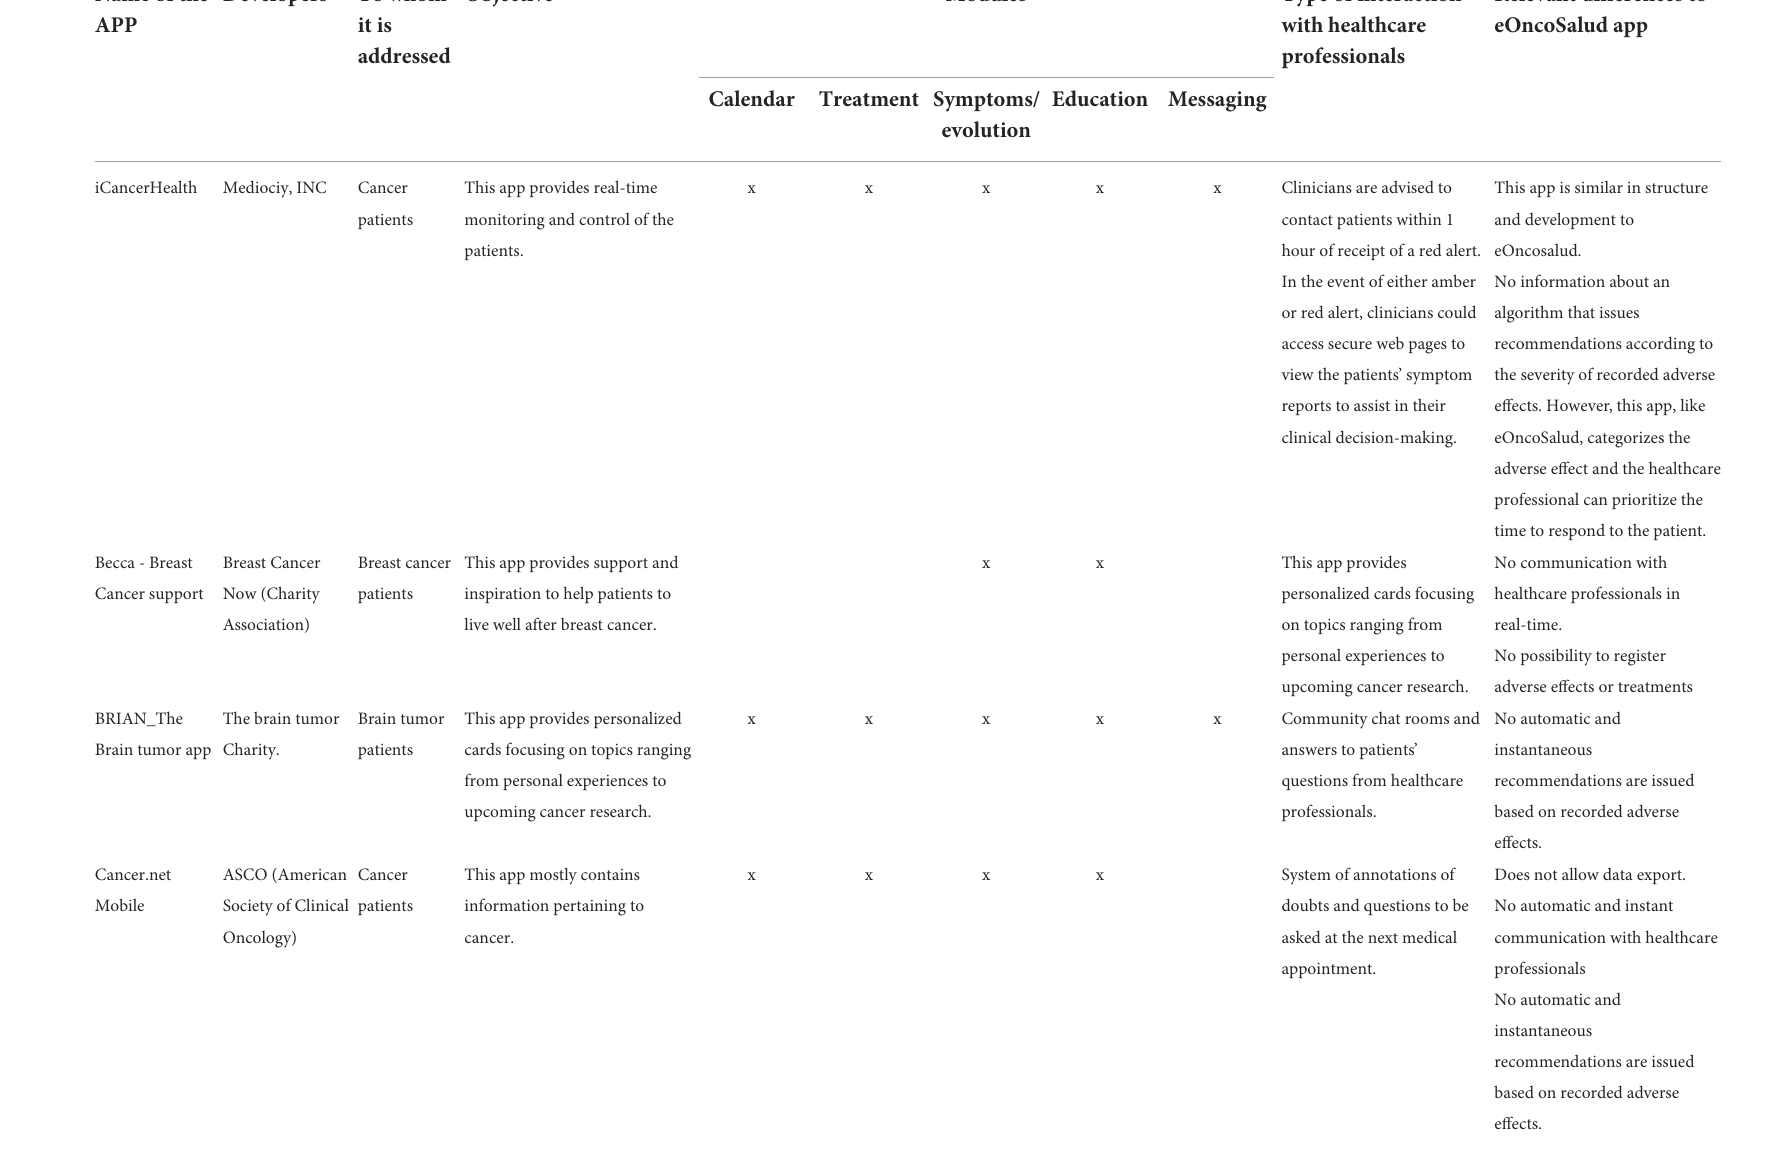
TABLE 5 Differences between some of the apps available for cancer patients and